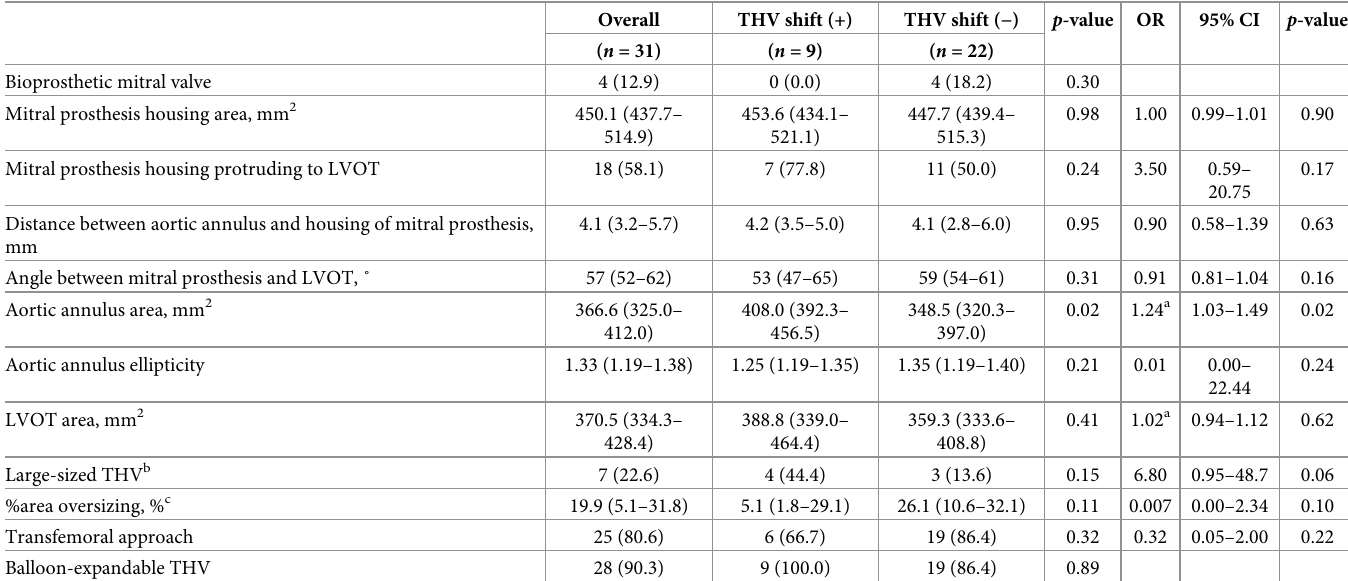
Table 3. Predictors of THV